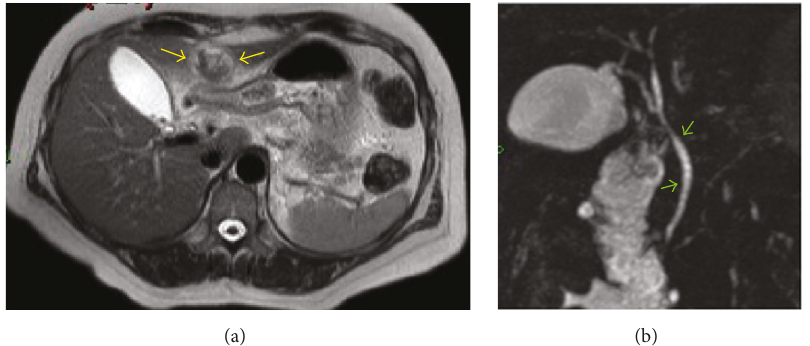
Figure 2: MRCP (magnetic resonance cholangiopancreatography). Axial view (a) showing thrombosed falciform ligament (yellow arrows). Projective coronal view (b) showing patent bile duct with no stones (green